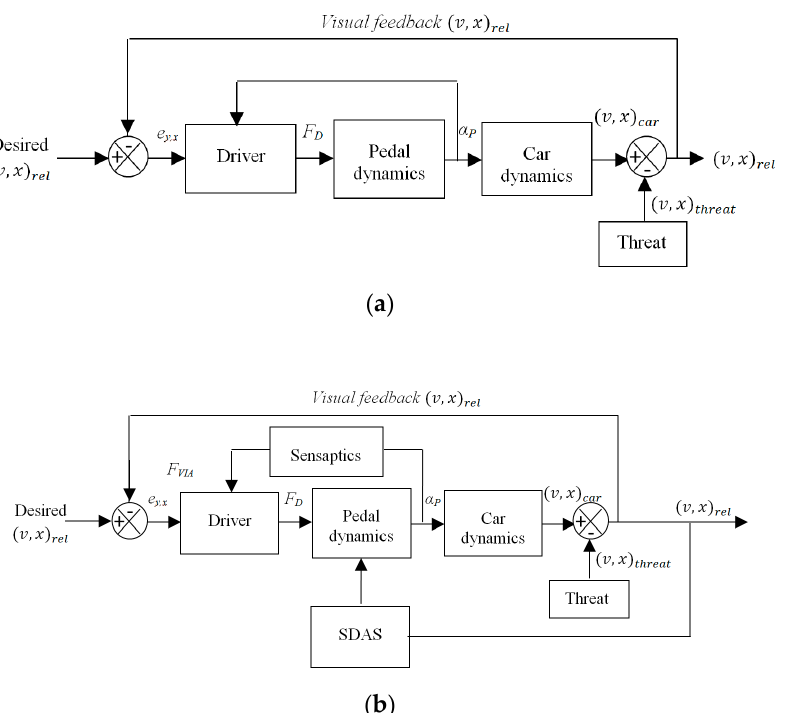
Figure 5. Control block diagram; ( a ) longitudinal control of the car, ( b ) longitudinal control with haptic feedback.